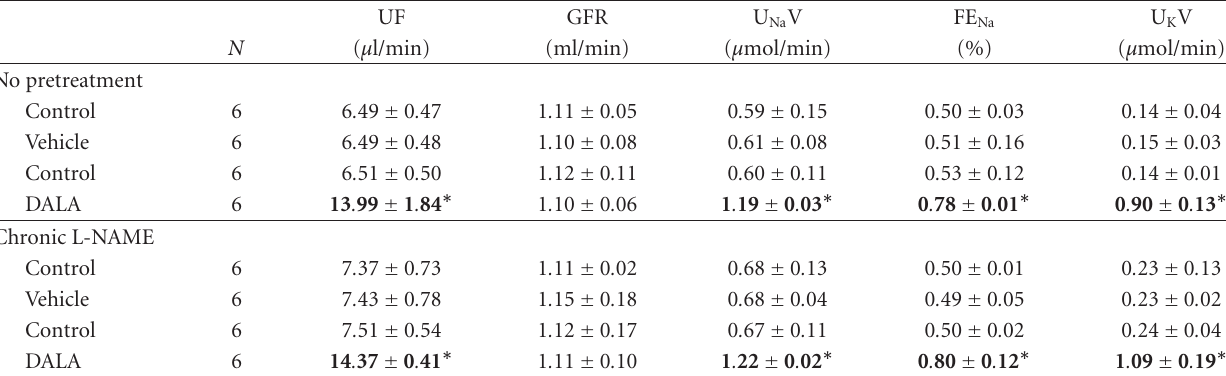
Table 2: E ff ects of increases in endogenous CO (DALA 80 μ mol/Kg, IV) on glomerular filtration rate (GFR), urine flow (UF), sodium